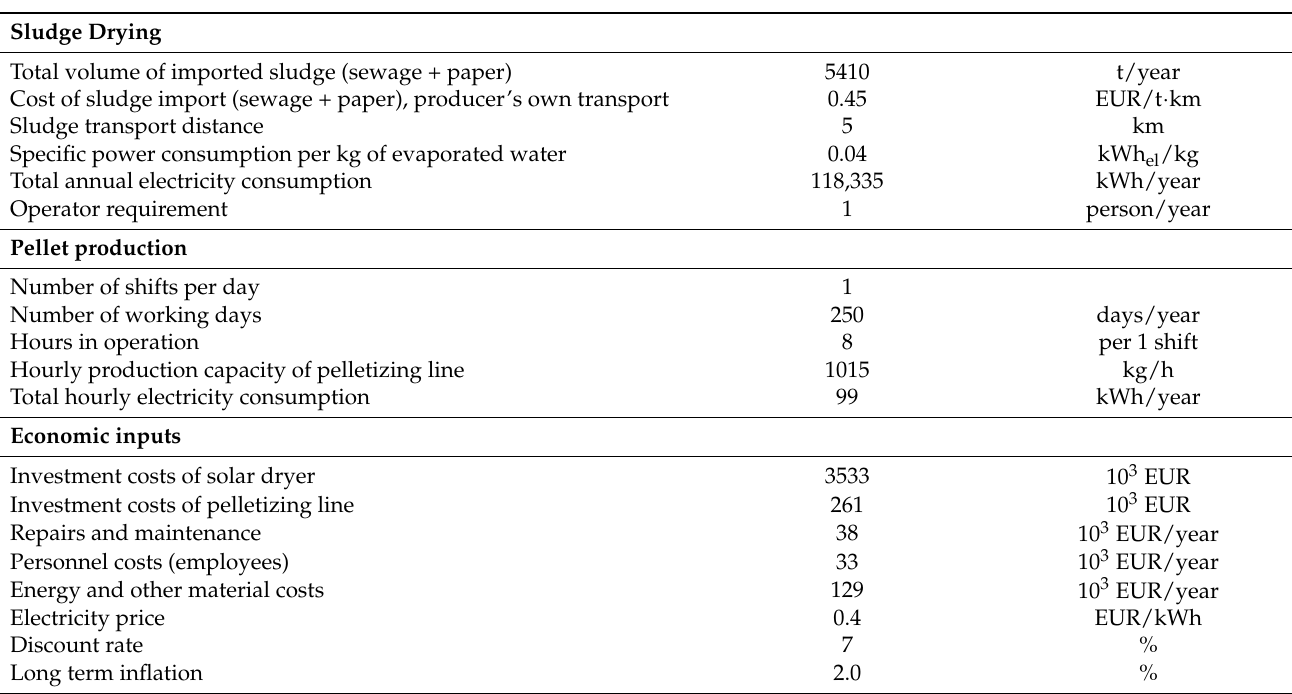
Figure 2. Boundaries for the economic evaluation. Table 2. Economic inputs [43,44].